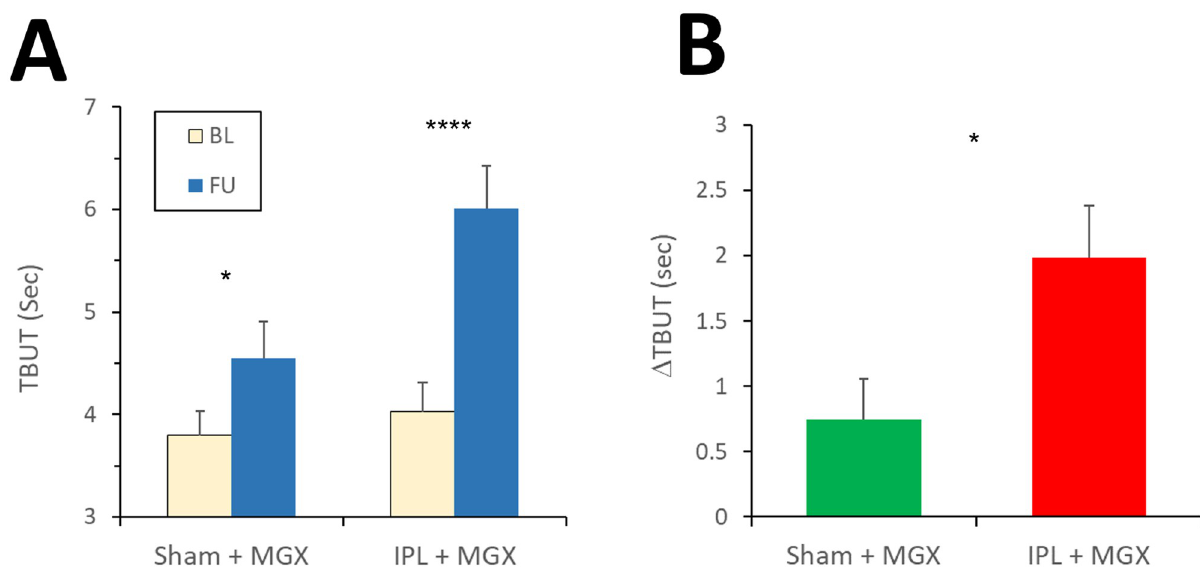
Fig 2. Change of primary outcome (TBUT). A. Absolute values of TBUT. Statistical tests within arms: paired two-sided t-test; �� : p < 0.01; ���� : p < 0.0001. B. Δ TBUT (the change of TBUT from BL to FU). Statistical test between arms: least squares fit of Δ TBUT. �� : P < 0.01.